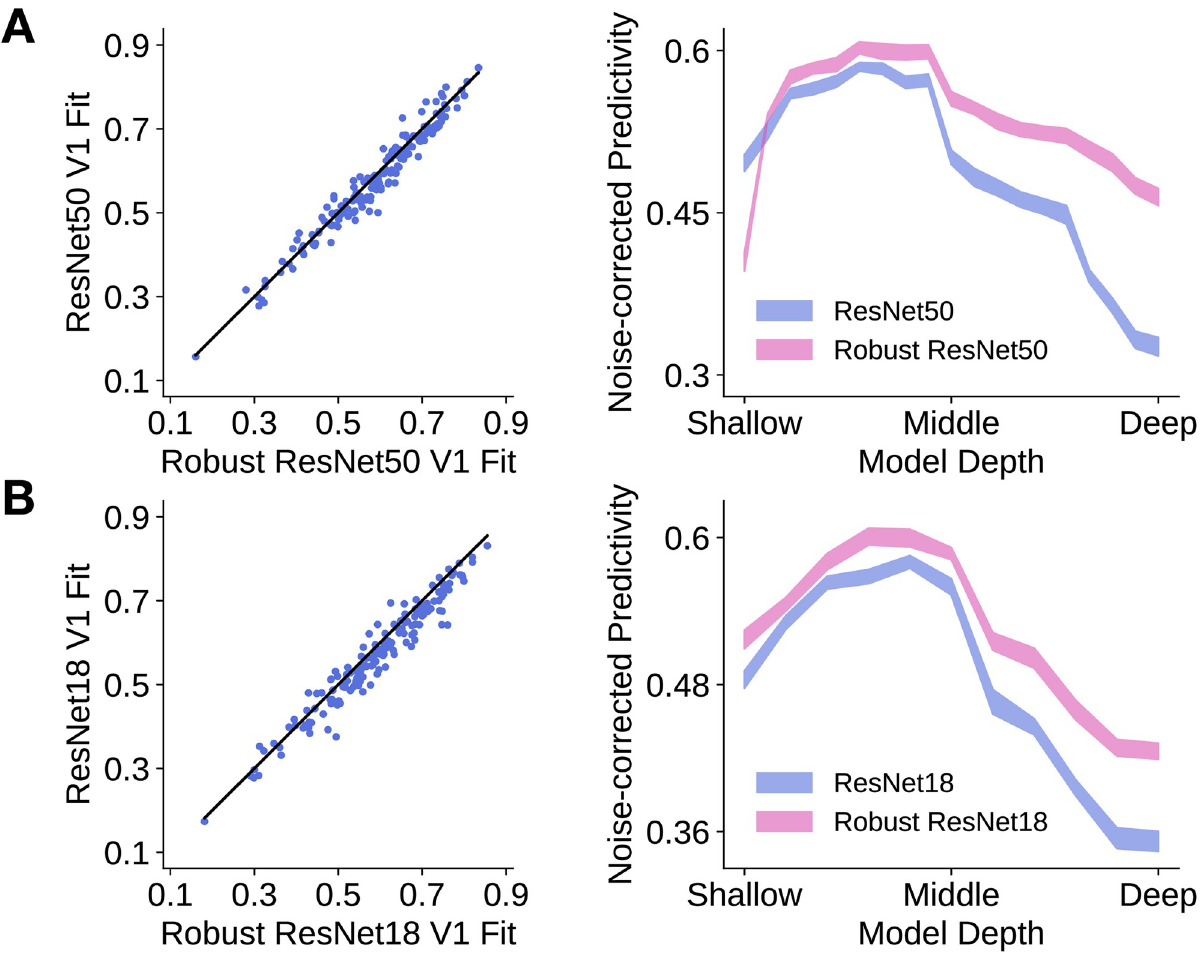
Fig 5. Robust models better predict macaque V1 neural responses than non-robust models. The noise-corrected predictivity for a neuron was defined to be the correlation between the predicted and observed responses, corrected by the neuron’s reliability. A . Left: For most neurons (represented by each dot), robust ResNet-50 has higher neural predictivity than non-robust ResNet-50. The black line denotes the identity line. Right: Median neural predictivity across neurons of a robust and non-robust ResNet-50 across model layers. Shaded region indicates the standard deviation of the median neural predictivity across 20 train-test image splits. B . As in A , but for robust and non-robust ResNet-18. For both ResNet-50 and ResNet- 18, the neural predictivities for the robust models are significantly better than those of the non-robust models ( p < 0.01 for both architectures). Statistical significance was determined by bootstrap resampling of the neurons (with replacement) 10 000